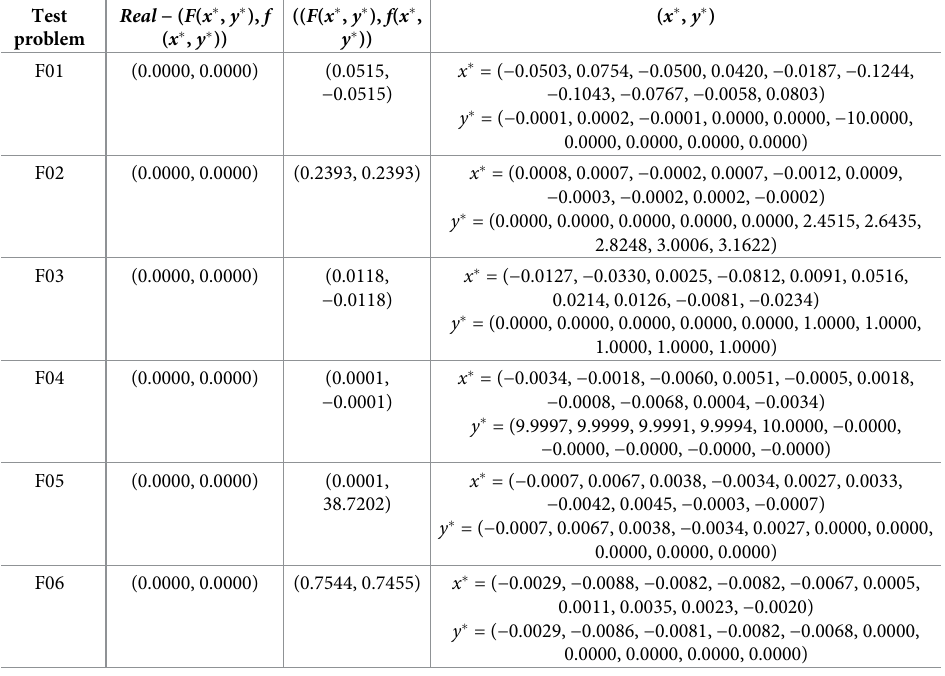
Table 3. Comparison between the results obtained by TCEA and the real objective values in the case of 20